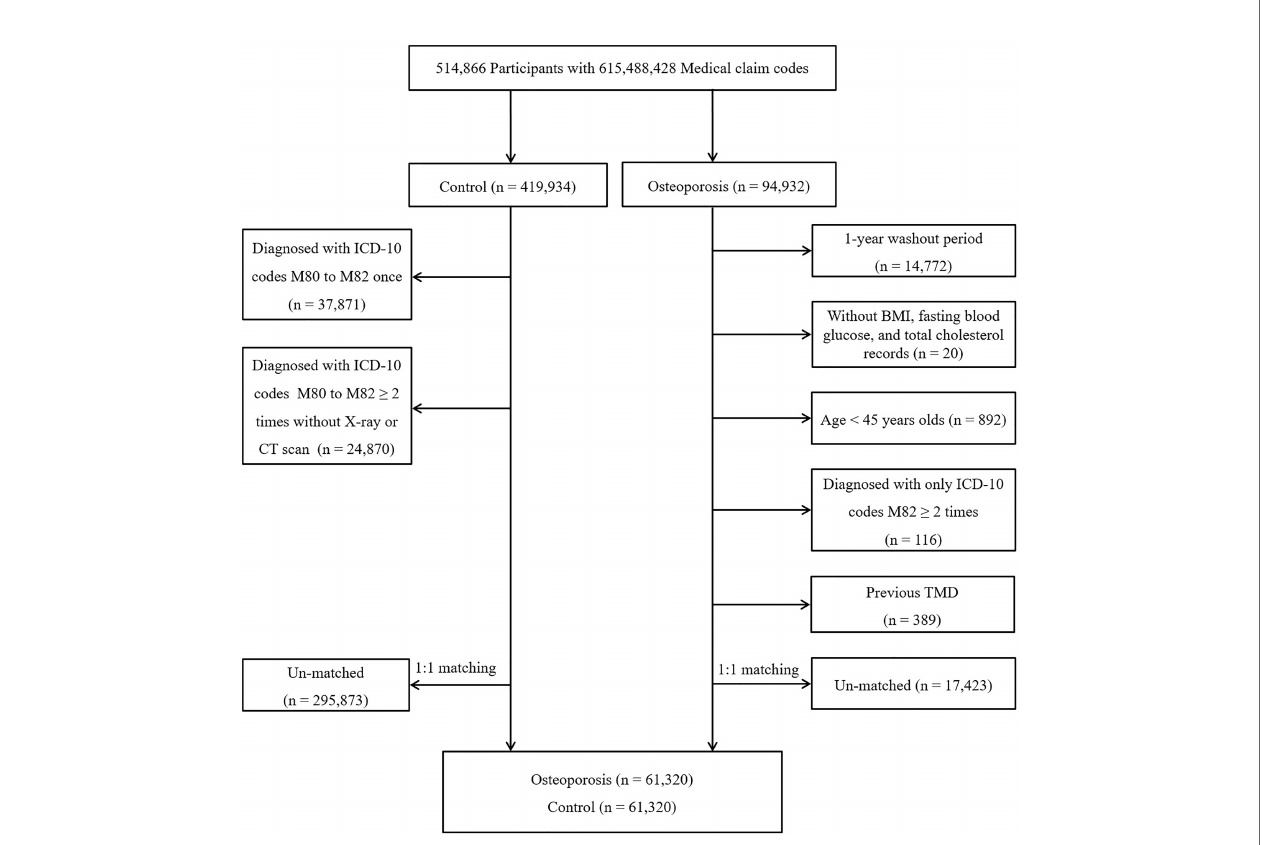
FIGURE 1 | A schematic illustration of the participant selection process used in the present study. From a total of 514,866 participants, 61,320 osteoporosis participants were 1:1 matched with 61,320 control participants for age, sex, income, and region of